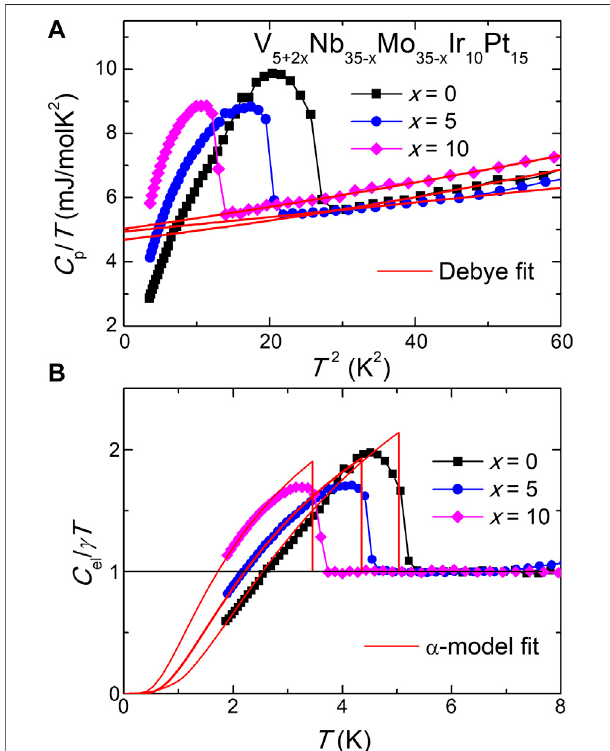
FIGURE 4 | (A) Low-temperature speci fi c heat for the V these HEAs. The solid lines are fi ts to the data by the a -model.